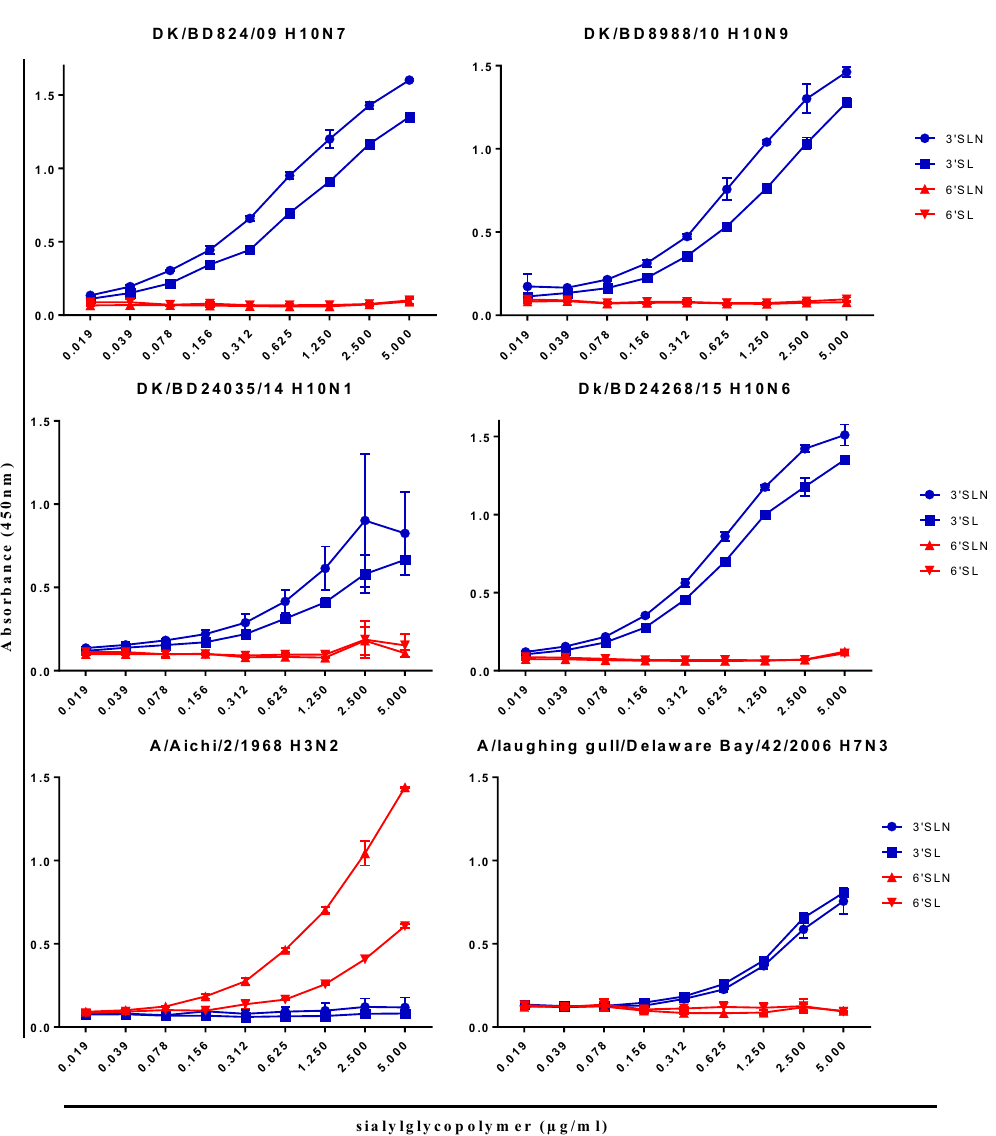
Figure 6. Receptor-binding specificity of H10 AIVs. Binding of H10 AIVs to the biotinylated sialylglycopolymers 3 ′ sialyllactosamine (3 ′ SLN), 3 ′ sialyllactose (3 ′ SL), 6 ′ sialyllactosamine (6 ′ SLN), and 6 ′ sialyllactose (6 ′ SL) were measured. A/Aichi/2/1968 (H3N2) and A/laughing gull/Delaware Bay/42/2006 (H7N3) were used as species-specific controls.